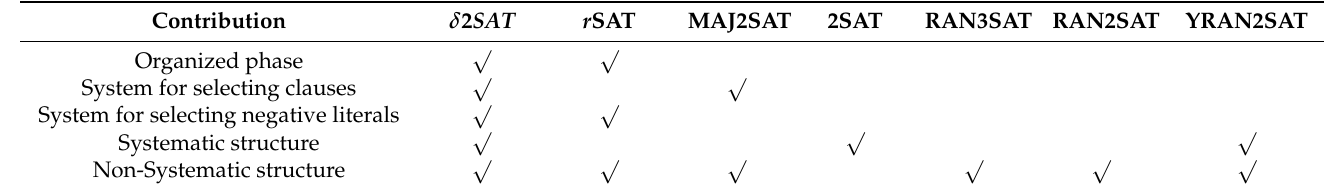
Table 18. A summary of comparative analysis between δ 2 SAT and other